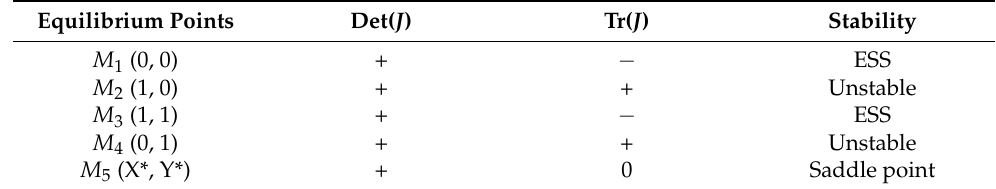
Table 3. Equilibrium points for determinants and traces (with the non-supervision of the central